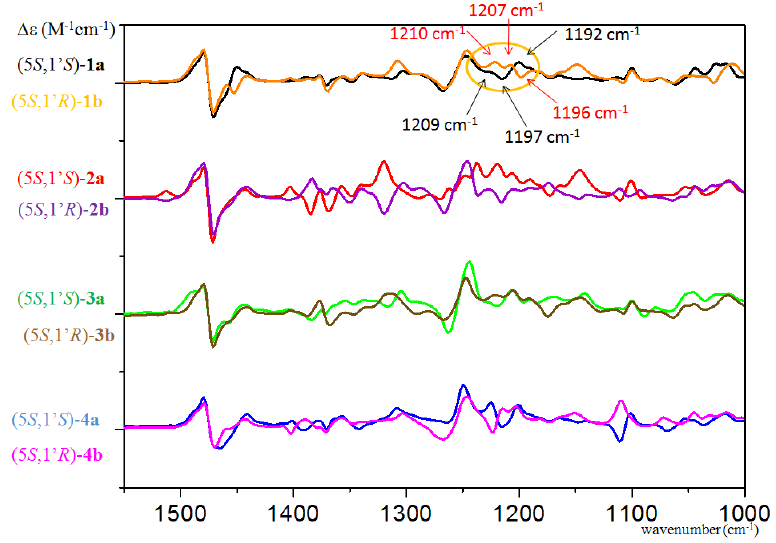
Figure 7. Experimental VCD curves of (5 S ,1 ′ S ) ‐ 1–4a overlapped with those of the epimeric (5 S ,1 ′ R ) ‐ 1–4a (CDCl 3) .